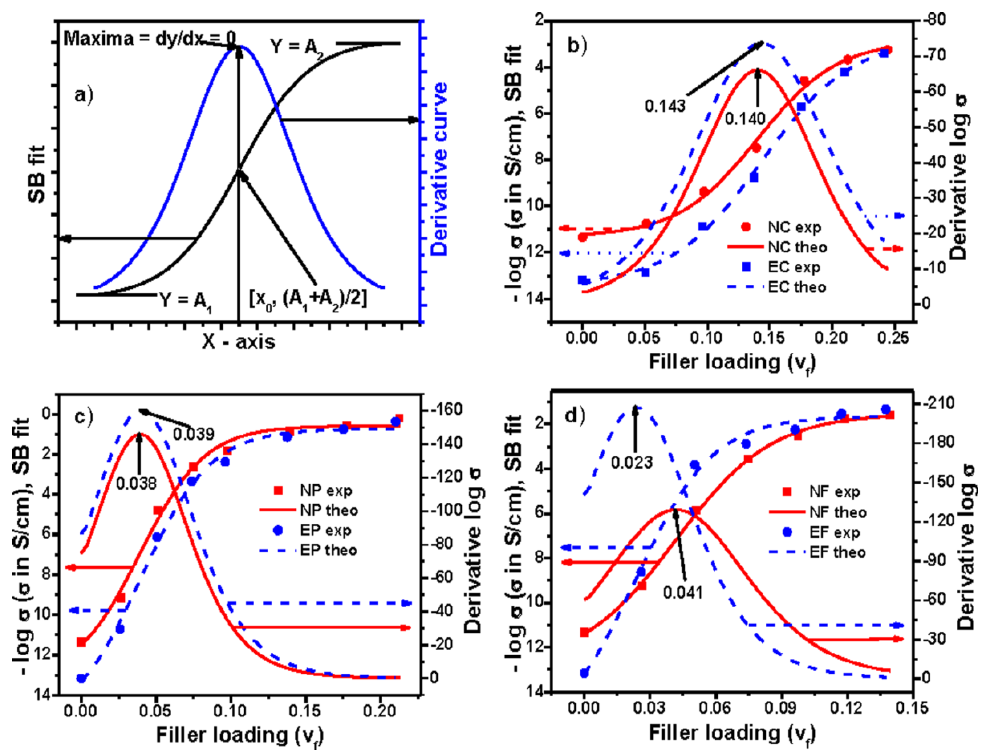
Figure 4. Experimental, theoretical, and derivative curves: ( a ) an ideal curve; ( b ) Conductex black filled; ( c ) Printex black filled; and ( d ) SCF filled composites based on Sigmoidal–Boltzmann model.